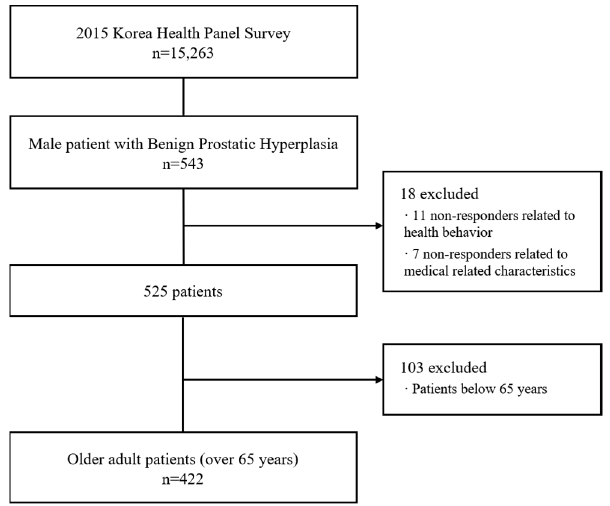
Figure 1. Flowchart. Figure 1.